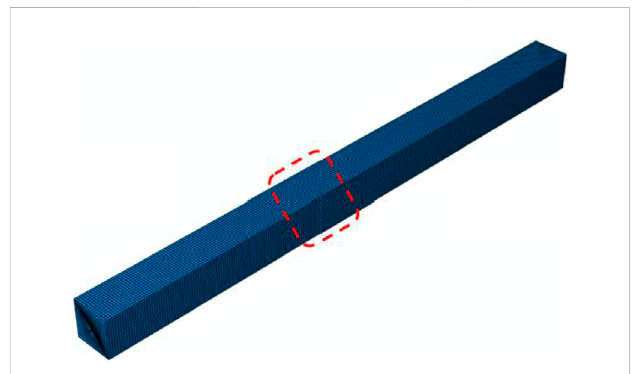
FIGURE 2 Overall fi nite element model grid